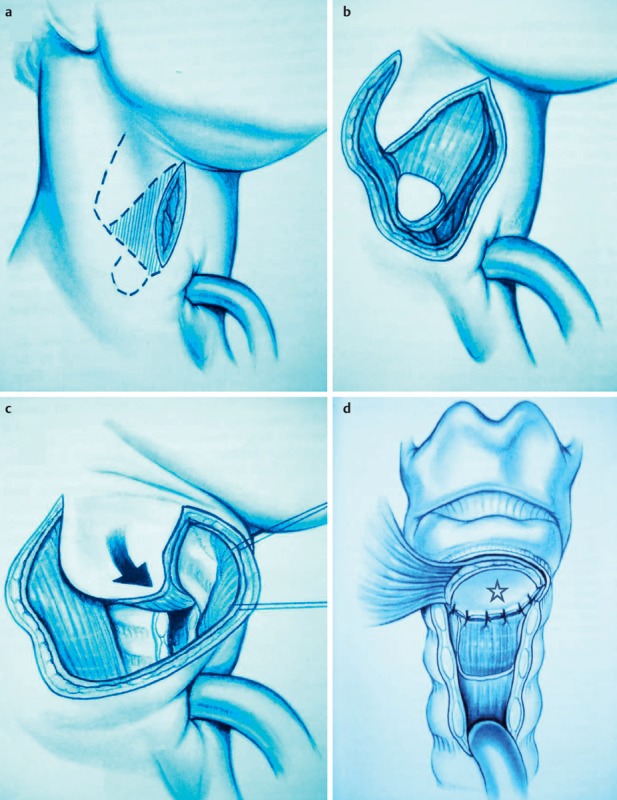
a – incision for the skin-platysma-fascia graft, hatched areas = parts of the flap are de-epithelized in order to place them under the skin, via the paramedian incision, the trachea and cricoid cartilage are exposed; b – the graft is circumcised, the platysma with its fascia on the inferior surface is prepared from the cervical muscles; c – after suturing the cranially pedicled mucosal flap from the posterior tracheal wall as covering on the side of the trachea, the graft is also used for defect covering of the donor site of the mucosal flap; d – donor site of the cranially pedicled mucosal flap of the posterior tracheal wall (star) is visible, partial resection of a part of the 1st and/or 2nd tracheal ring in order to avoid pressure on the pedicle.